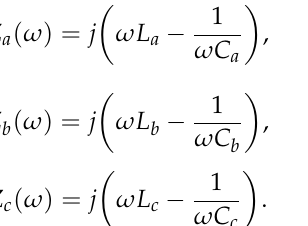
Figure 1. The three arms of a single-tuned filter. The arms impedances